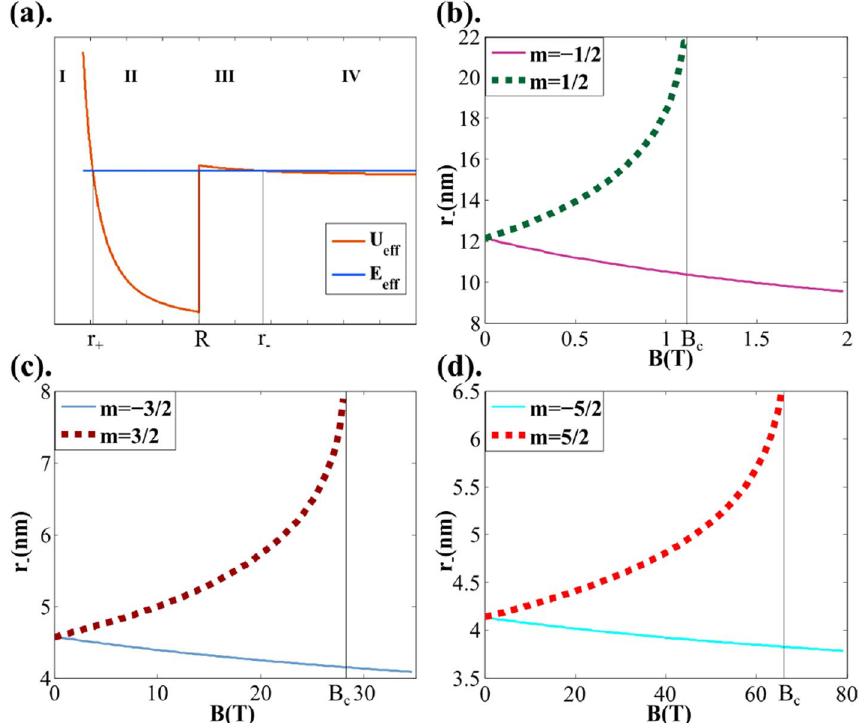
Figure 2. ( a ) Effective energy E eff (blue curve) and effective potential U eff (red curve) of a graphene quantum dot with radius R . The plot can be divided into four regions along the r axis (I, II, III, and IV), in which the quasi-bound states exist in region II. Panels ( b – d ) plot the r 1 / 2, 3 / 2, and 5 / 2, respectively ( R 4nm ). These plots are related to the width of the energy m = ± ± ± = spectrum. The corresponding quasi-bound states become bound states when B exceeds the critical magnetic 1.1T for m=1/2; in the higher angular momentum channels, we obtain field strength B c ( B c 1 / 2 | m = ≈ 28TandB c 66T B c 3 / 2 m 5 / 2 | m = ≈ | ≈ =